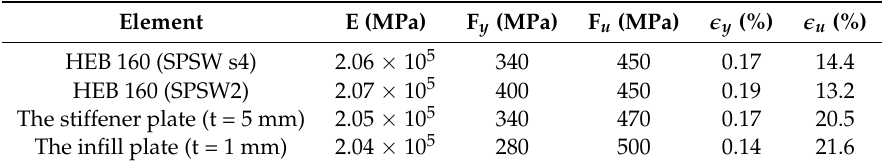
Figure 1. Experimental specimens which are using to verify Abaqus software [26] ( a ) SPSW2, and ( b ) SPSW s4 models, ( c ) dimension details of the SPSW s4 model. Table 2. Mechanical properties of steel material used in modeling